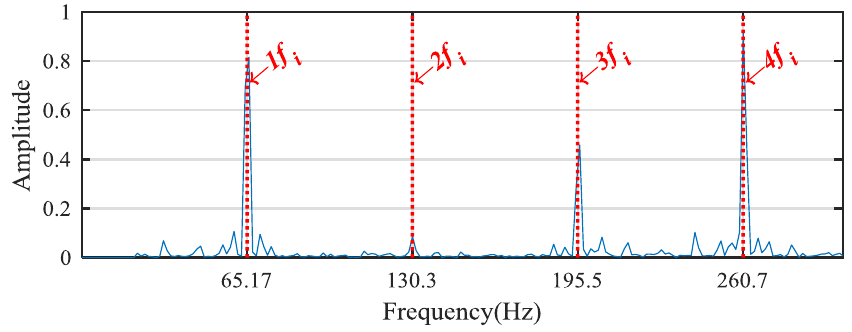
Figure 12. Results of the proposed method.